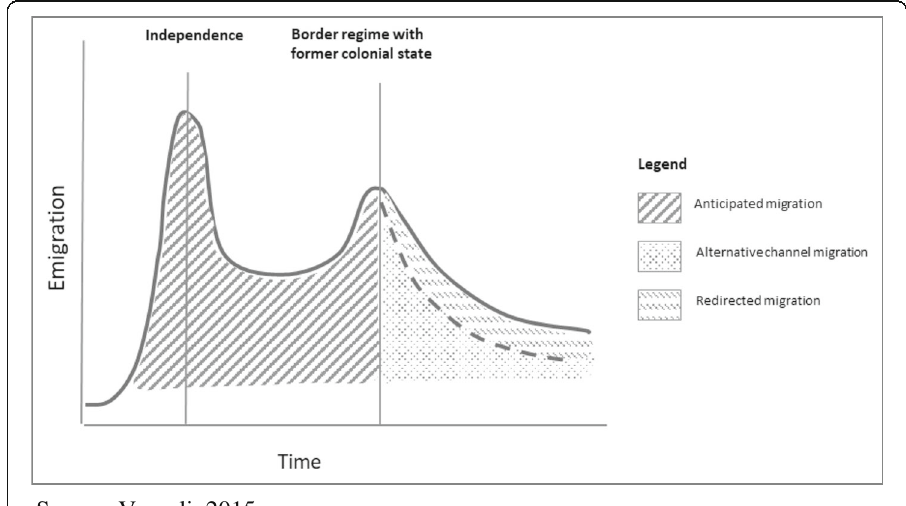
Fig. 8 Schematic representation of how independence before the establishment of border regime affects international